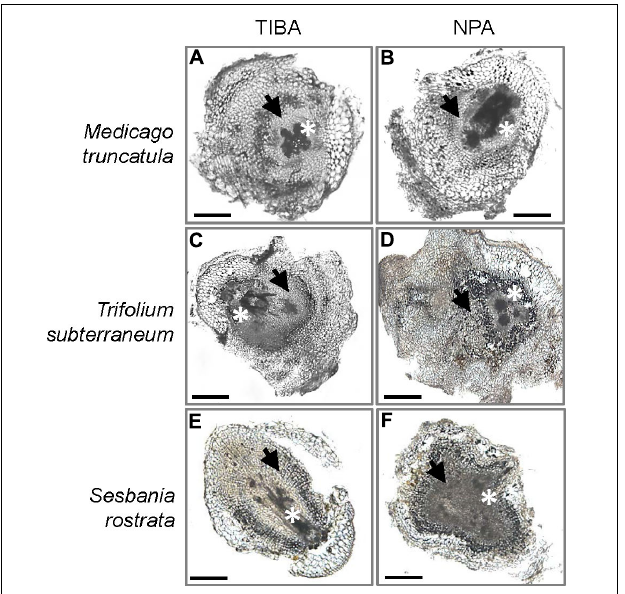
FIGURE 6 | Cross sections of pseudonodules induced by TIBA or NPA treatment. Pseudonodules were induced on the roots of (A,B) M. truncatula , (C,D) T. subterraneum (subclover), and (E,F) S. rostrata . Asterisks indicate location of the primary root vasculature. Arrows indicate pericycle and endodermal cell divisions. Scale bars represent 500 µ m. Abbreviations: TIBA, 2,3,5-triiodobenzoic acid and NPA, 1- N -naphthylphthalamic